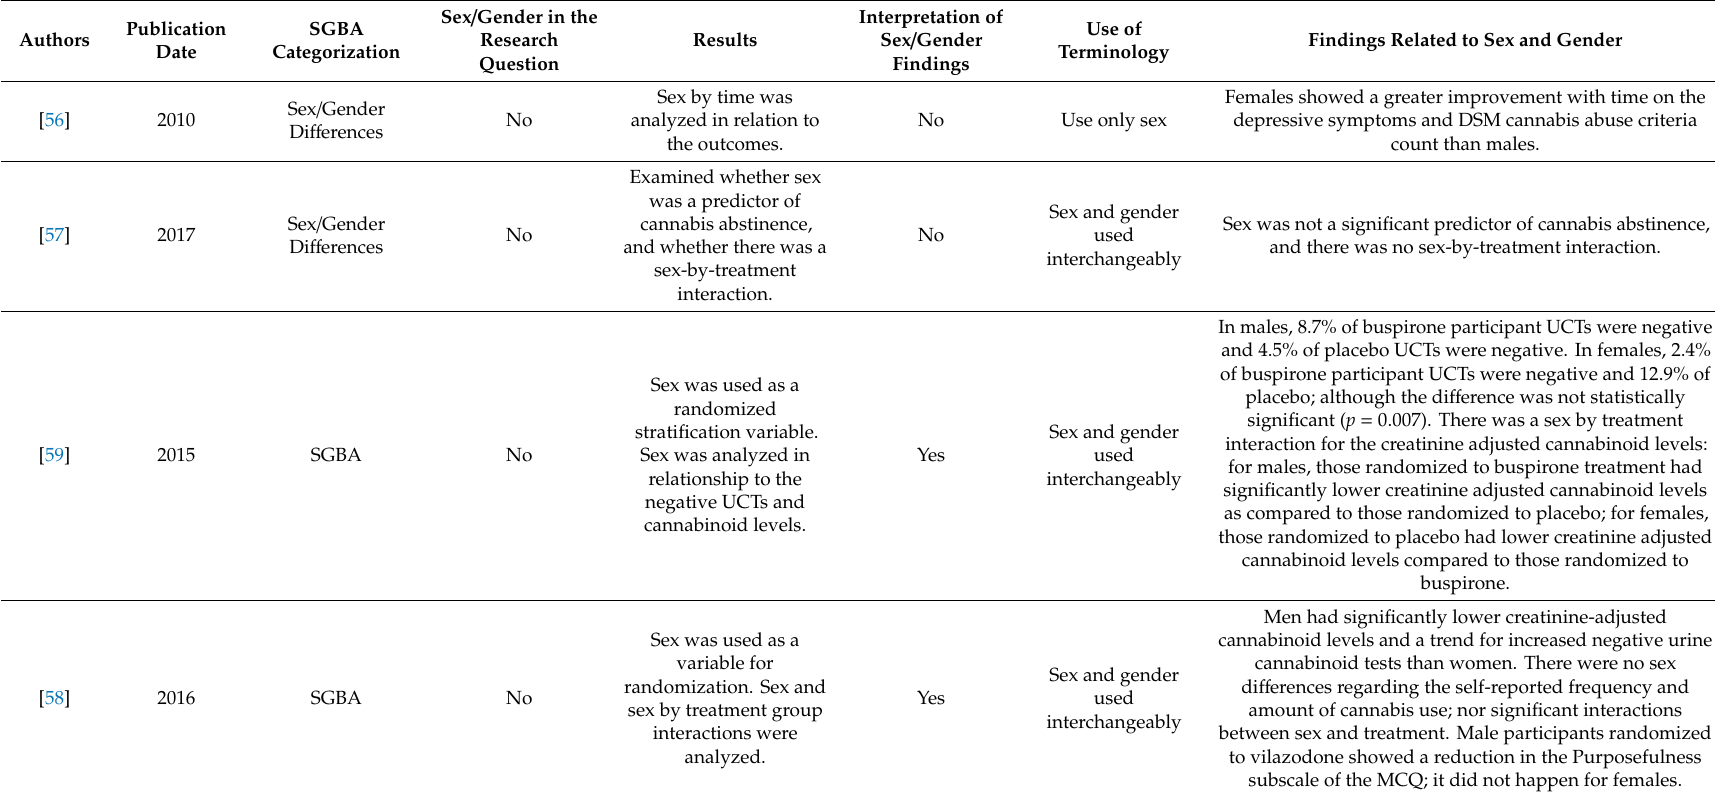
Table 3. SGBA applied to cannabis pharmacological